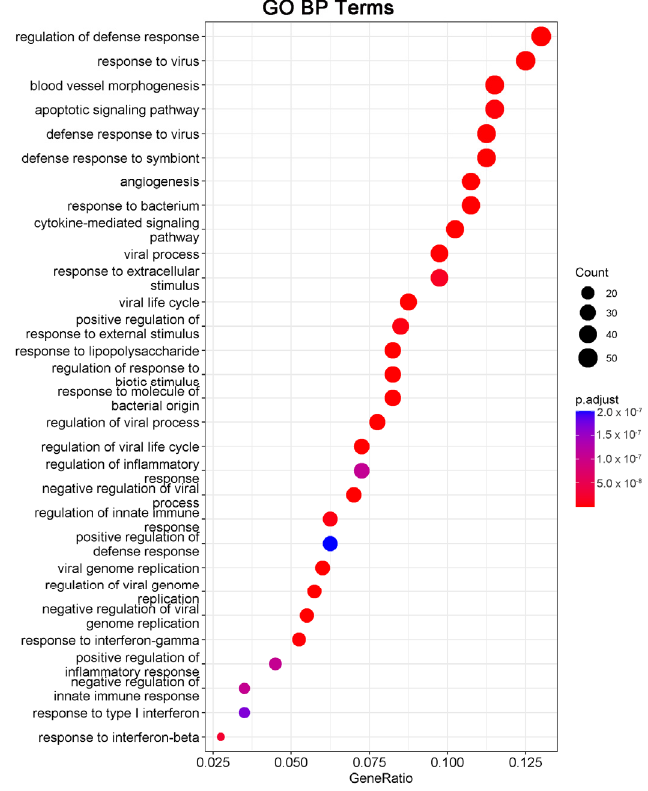
Figure 3. DEGs in 20(S)-GRh2-treated HeLa cells were analyzed by GO functional enrichment, and the top 30 functionally enriched terms annotated to BP are shown. GO, gene ontology; BP, biological processes; DEGs, differentially expressed genes; 20(S)-GRh2, 20(S)-ginsenoside Rh2.